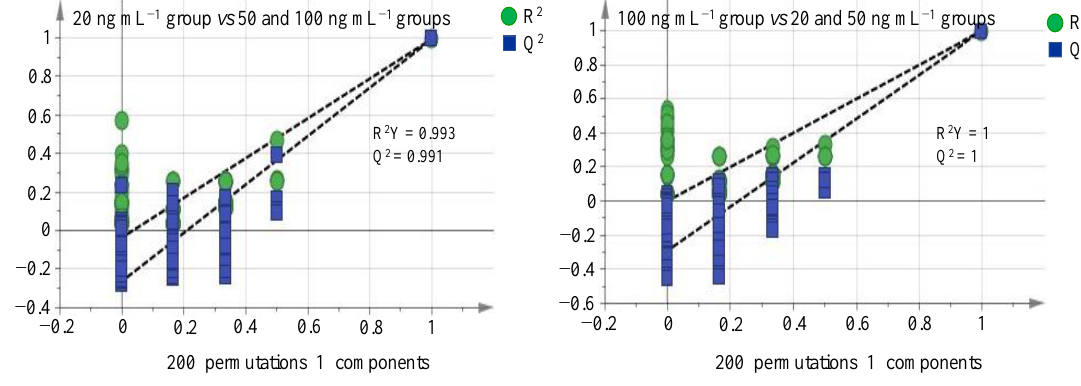
Figure 5. Permutation test plots of spiked lettuce sample groups. Table 2. Marker compounds screened in lettuce sample